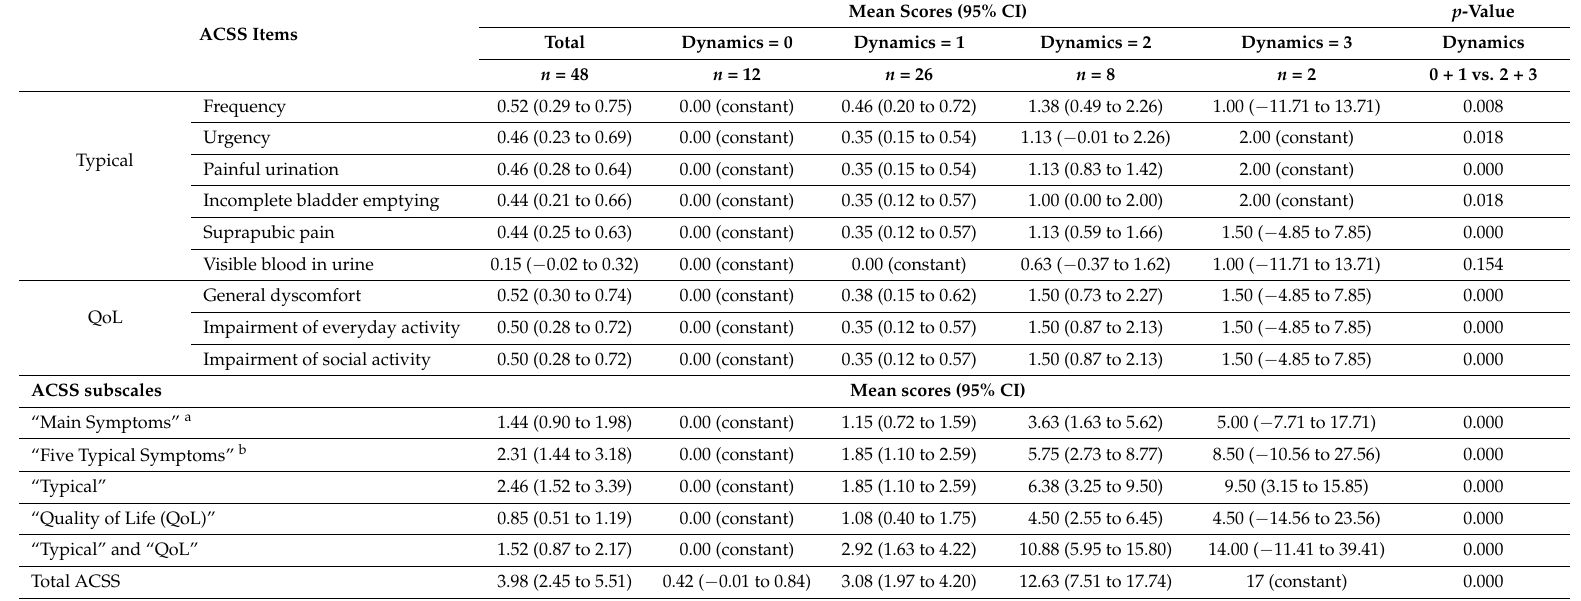
Table 5. Mean scores and 95% confidence intervals (CI) of ACSS items and subscales in 48 female patients according to scores of the “Dynamics” domain at the follow up